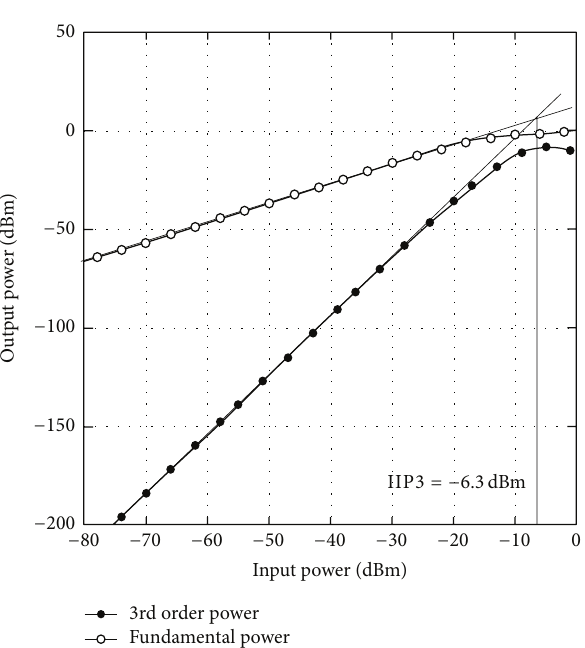
Figure 8: Two-tone IIP3 simulation at 5 GHz.